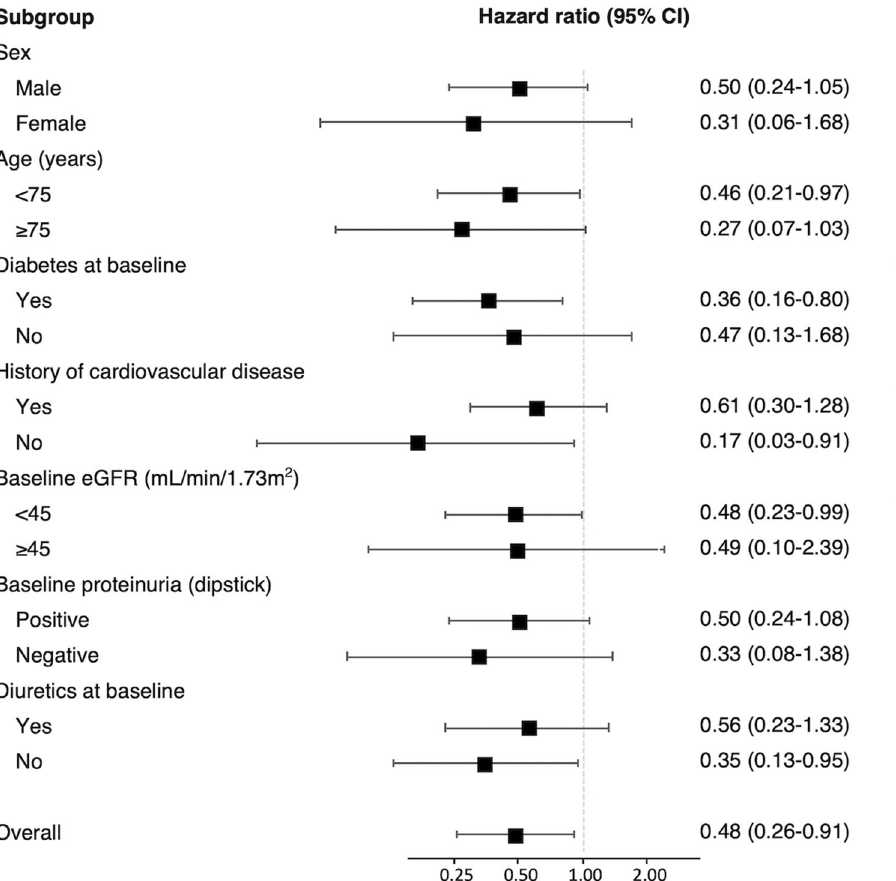
Figure 2. Hazard ratios of XOI use for the cardiovascular events for the subgroup according to the baseline variates. Hazard ratios were adjusted for age, sex, eGFR, history of cardiovascular disease or diabetes, smoking status, systolic blood pressure, serum uric acid, BMI ≥ 25 kg/m 2 , proteinuria (g/gCr), and use of diuretics. XOI xanthine oxidase inhibitor, CI confidence interval, eGFR estimated glomerular filtration rate, BMI body mass